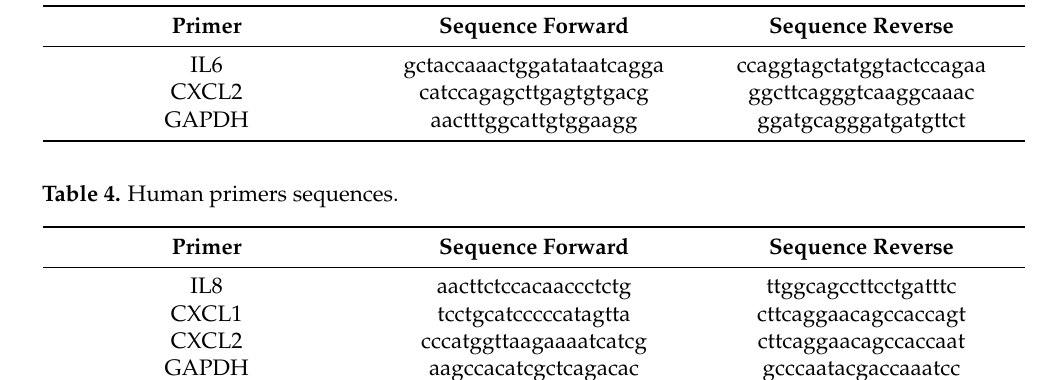
Table 3. Mouse primers sequences.